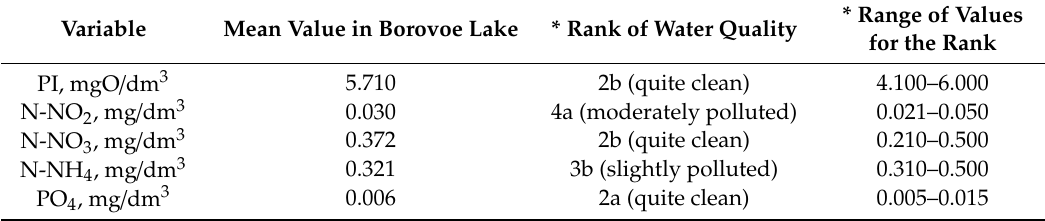
Table 6. Assessment of the organic pollution level of Lake Borovoe by nutrient content,